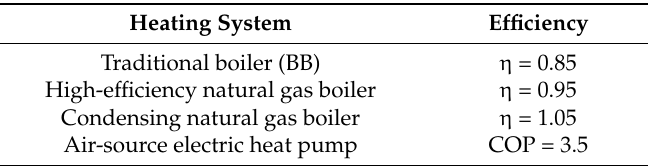
Table 9. Investigated heating primary